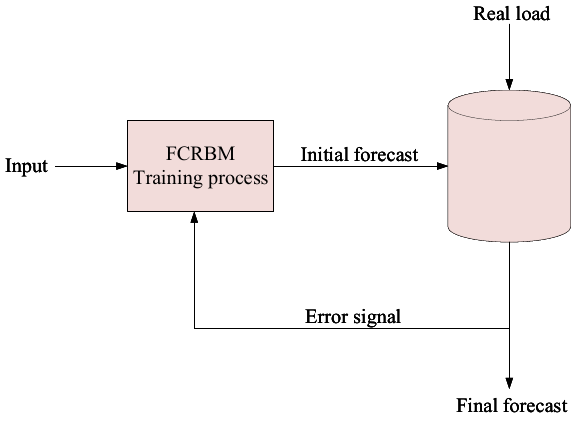
Figure 5. Training and learning process of the deep learning based FCRBM model with ReLU and multivariate autoregressive